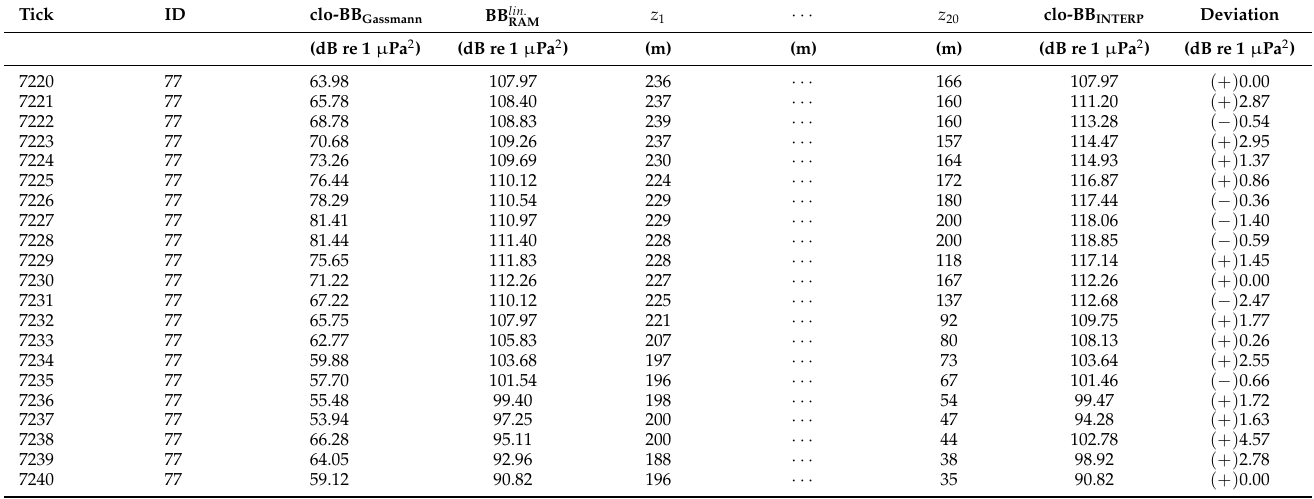
Table A3. Example—GBM inputs and